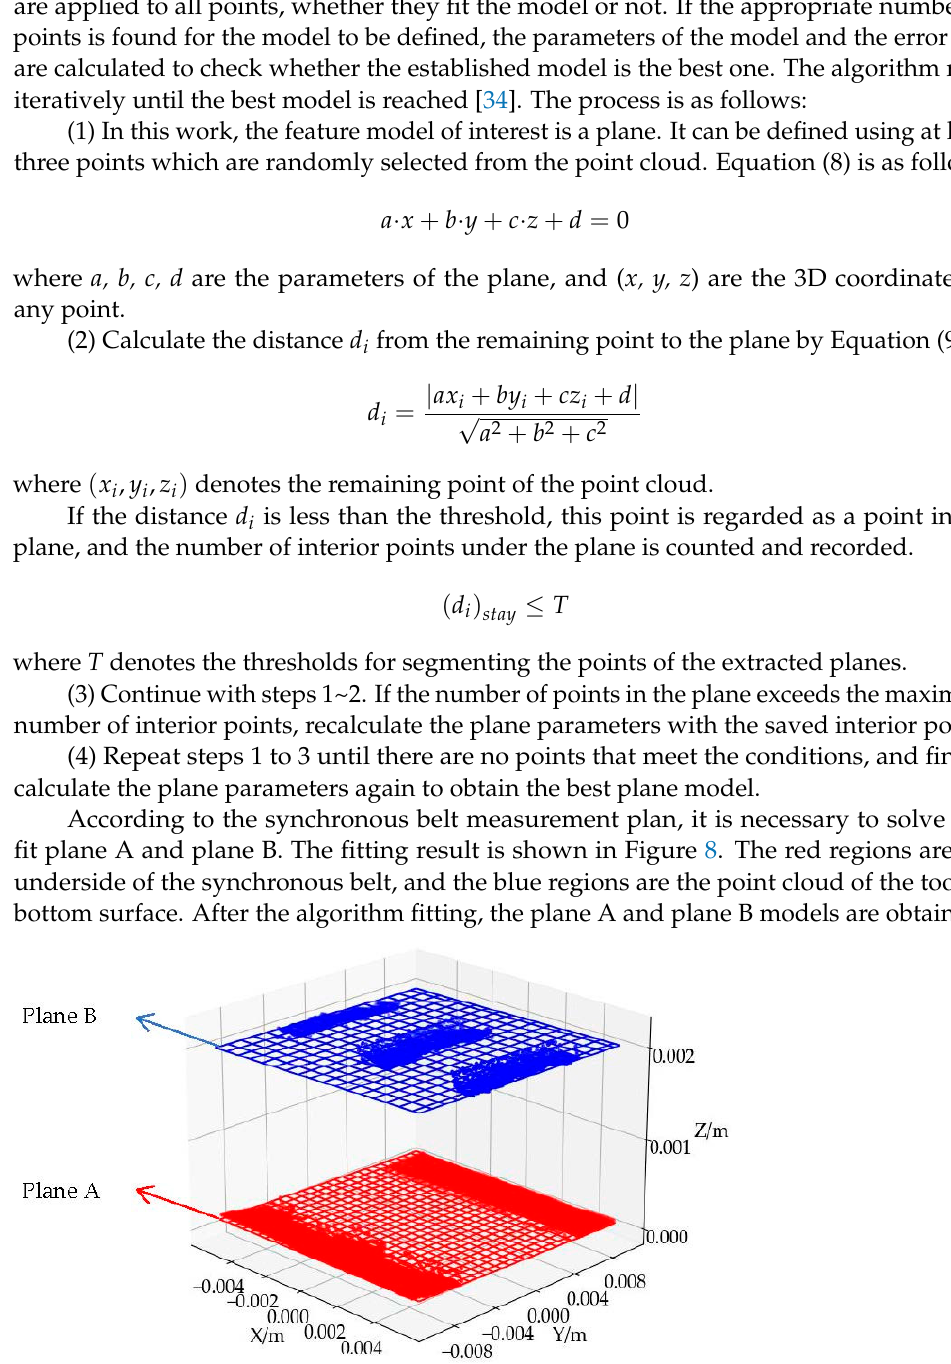
Figure 8. Fitting result of plane A and plane B.